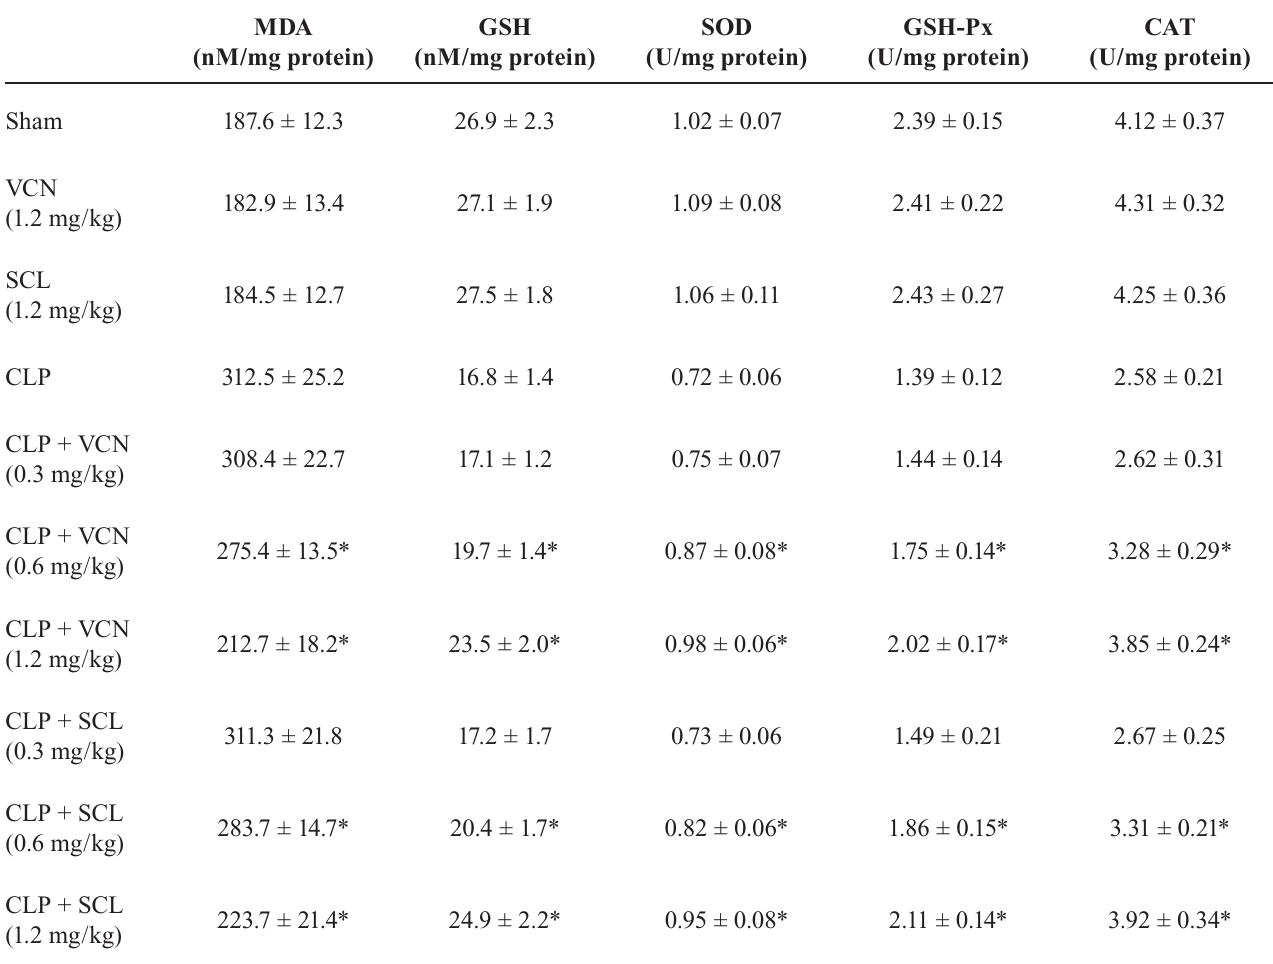
TABLE III - Effects of VCN or SCL treatment on MDA level and the activities of renal antioxidant enzymes in CLP-operated